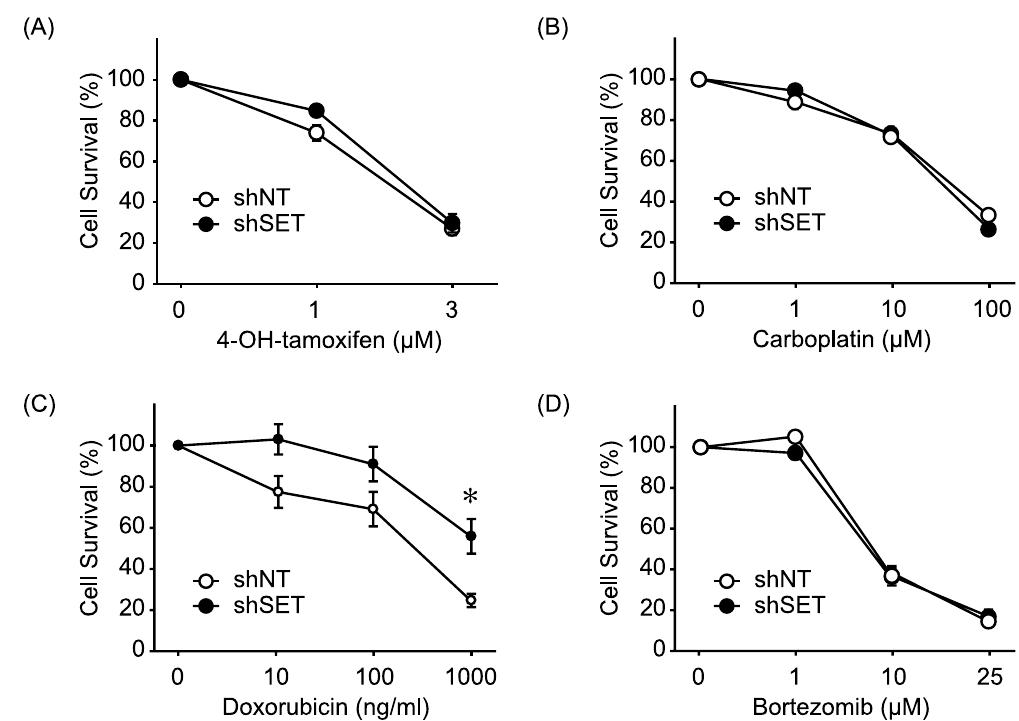
Figure 6. SET knockdown renders the canine breast cancer cells resistant to doxorubicin. Cell viability of CIP-m expressing shNT or shSET was analyzed by CCK8 after 48 hr treatment with 4-OH-tamoxifen ( A ), carboplatin ( B ), doxorubicin ( C ), and bortezomib ( D ). Cell viabilities were normalized to non-treated control of each cell lines as 100%. Quantitative data from 3 independent experiments performed duplicate are shown. * P < 0.05 vs.